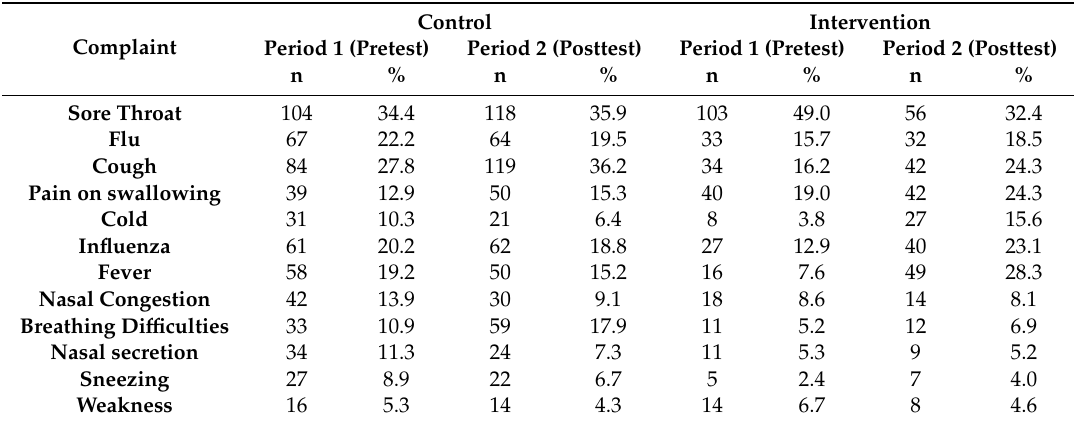
Table 2. The most frequent patient complaints associated with requesting antibiotics in the control and intervention groups in period 1 or